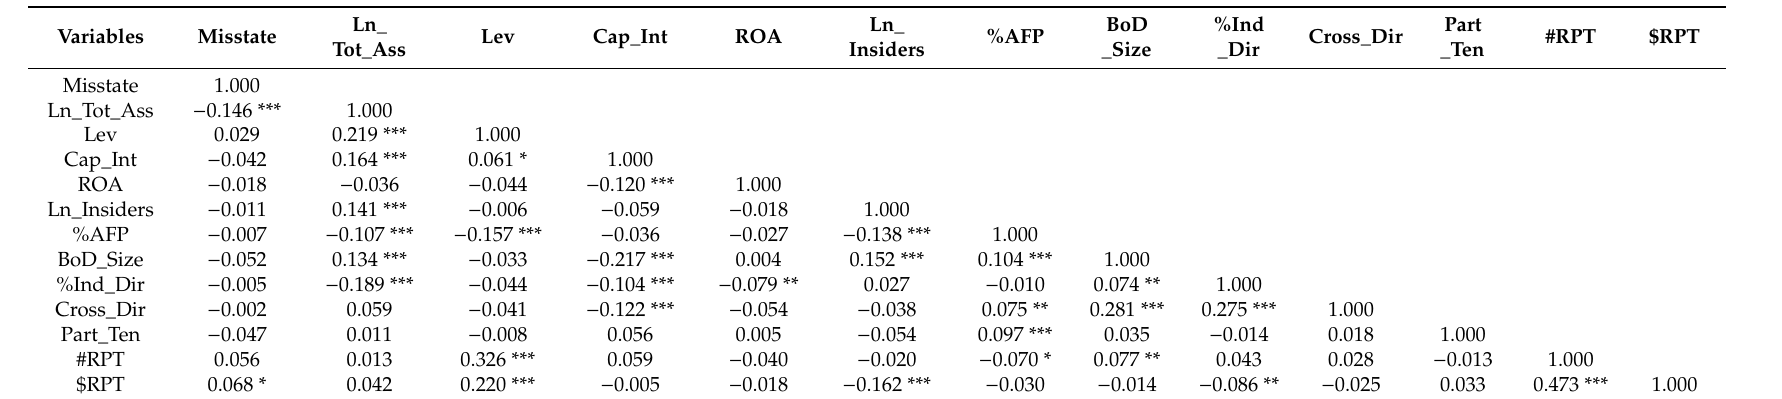
Table 2. Pearson